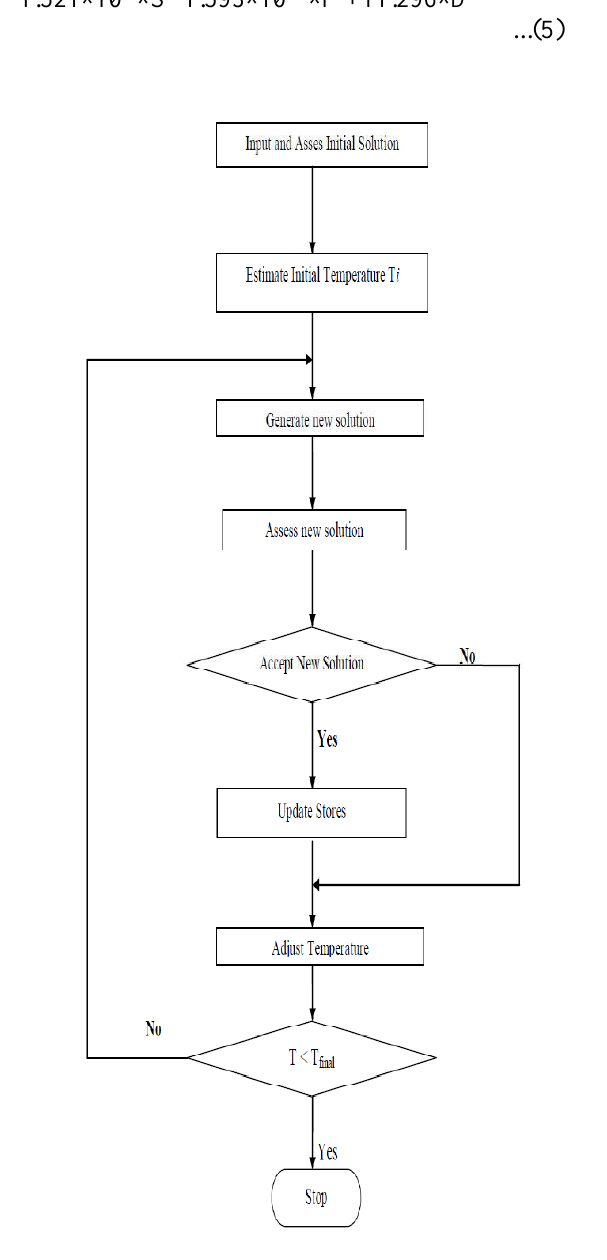
Fig. 8. Simulated Annealing